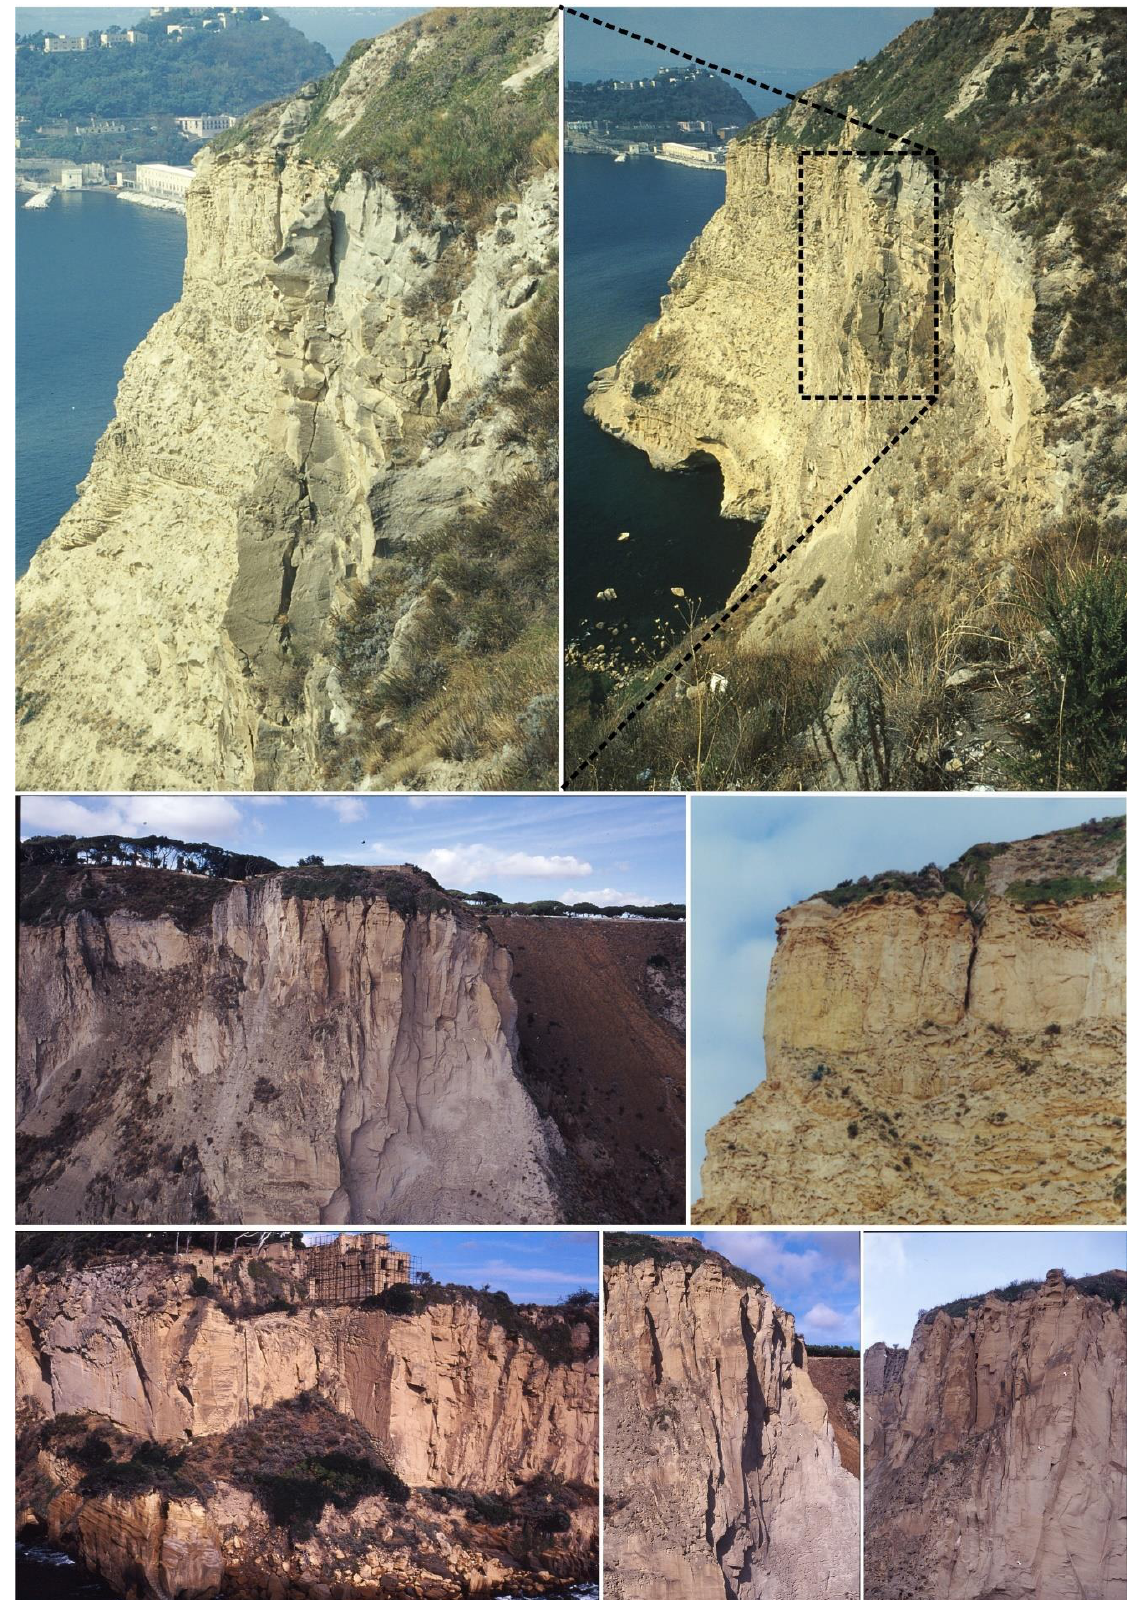
Figure 10. Beating fractures and rock-falls niches along the Coroglio-Trentaremi sea cliff. Unstable fractures, dihedrons and pinnacles set on high angle systems are well evident.